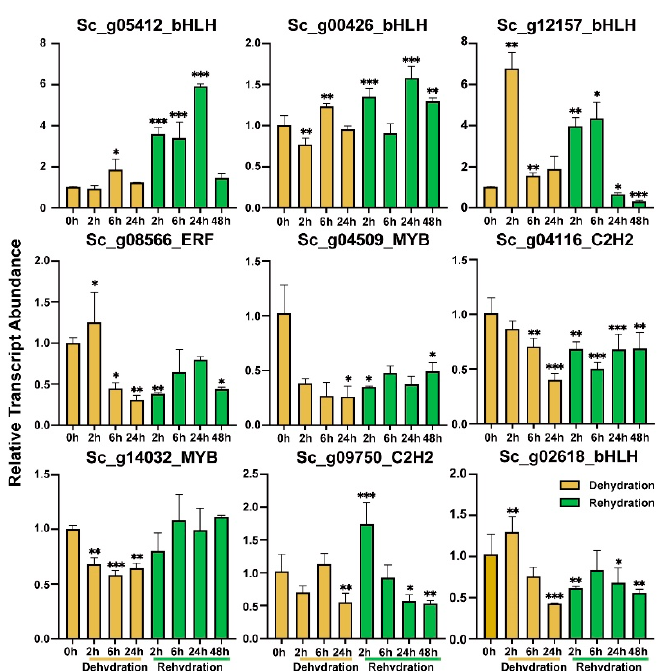
Figure 10. The relative transcript abundance analysis of nine represented TFs in response to dehydration (2, 6, and 24 h) and rehydration (2, 6, 24, and 48 h) stresses by RT-qPCR. Data are represented as means ± SD of three independent biological replicates of each treatment. The significant difference compared with the control (0 h), LSD multiple comparison tests: * p < 0.05, ** p < 0.01, ***, p < 0.001.